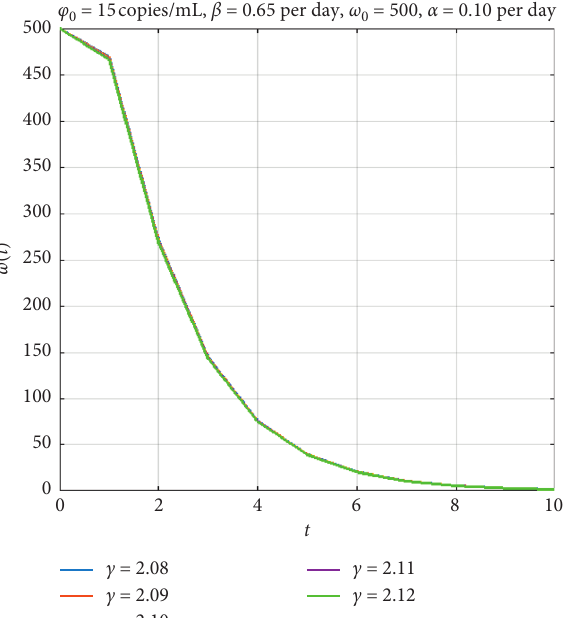
Figure 7: The number of infected cells ω for different values of time t and rate constant of viral particle clearance c with � 15copies/mL , β � 0 . 65 day − 1 , ω � 500 , and α � 0 . 10 day − 1 φ 0 0